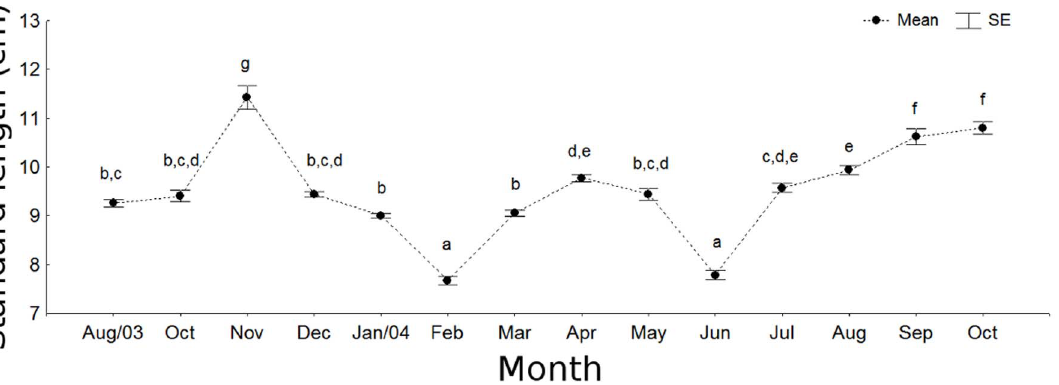
Figure 3. Temporal length variation. Temporal variation of standard length (cm) (mean 6 standard error; a =0.05) for Cathorops spixii sampled in Caraguatatuba Bight from August 2003 through October 2004. Different letters denote significant differences among months, discriminated by the SNK test; brackets on the x-axis include the number of observations in each case.